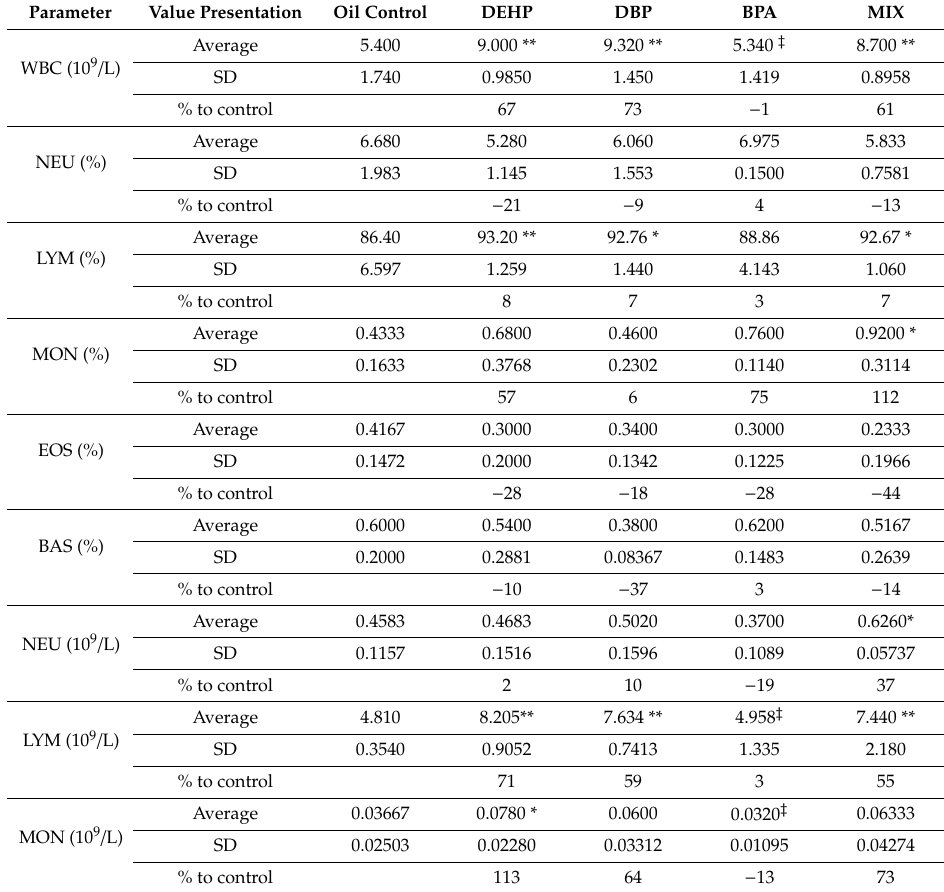
Table 5. Hematological parameters for male rats after 28 days of oral exposure to single investigated substances (DEHP, DBP, and BPA) and their mixture